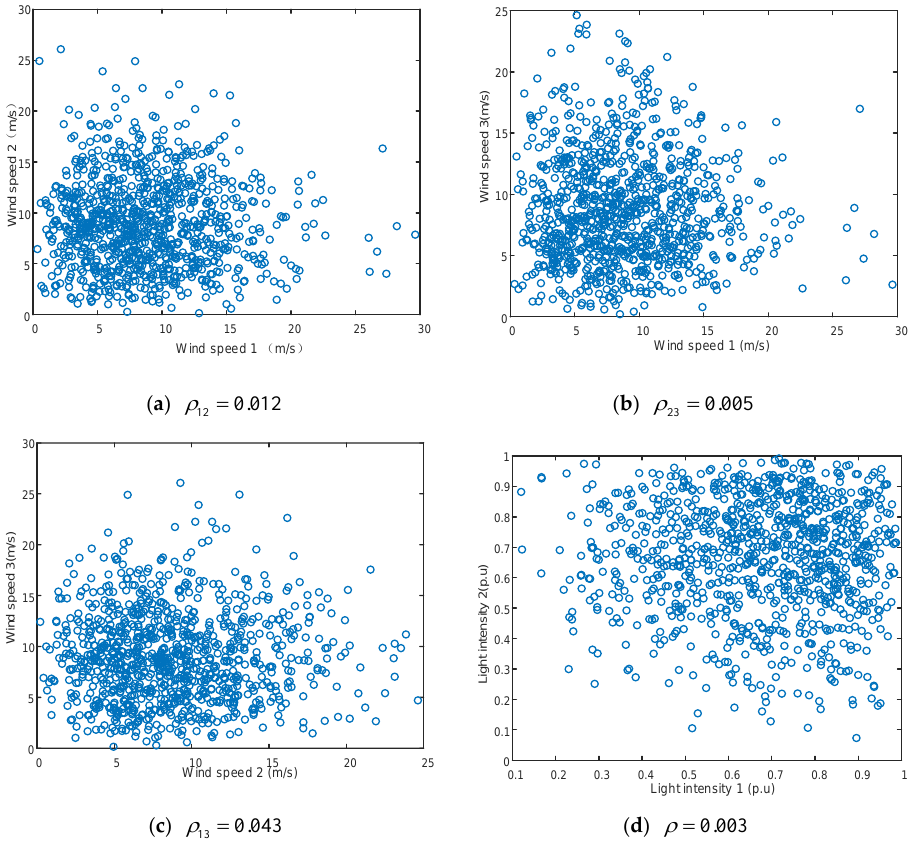
Figure 6. Results for PEM without the Nataf transformation for Case 1. Correlations in the wind speeds of ( a ) wind power plants 1 and 2, ( b ) wind power plants 1 and 3, ( c ) wind power plants 2 and 3, and ( d ) photovoltaic power plants.